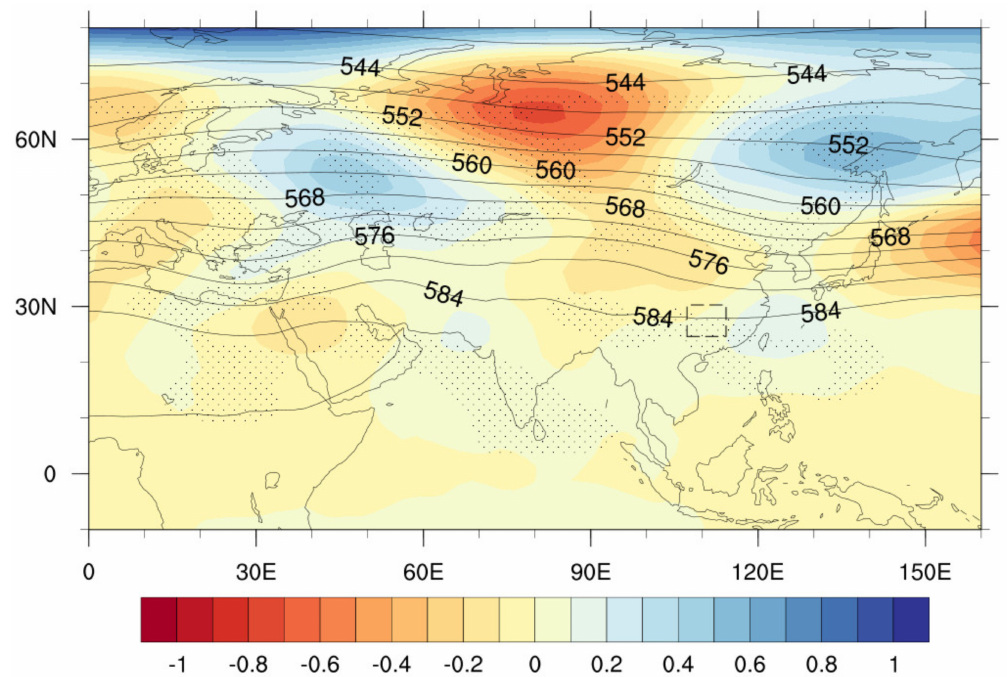
Figure 7. The 500 hPa height field of MME over the next 30 years (contour), the difference between the peak years and valley years (shaded), the dotted area indicates that it passed the 95% significance test; the same below.